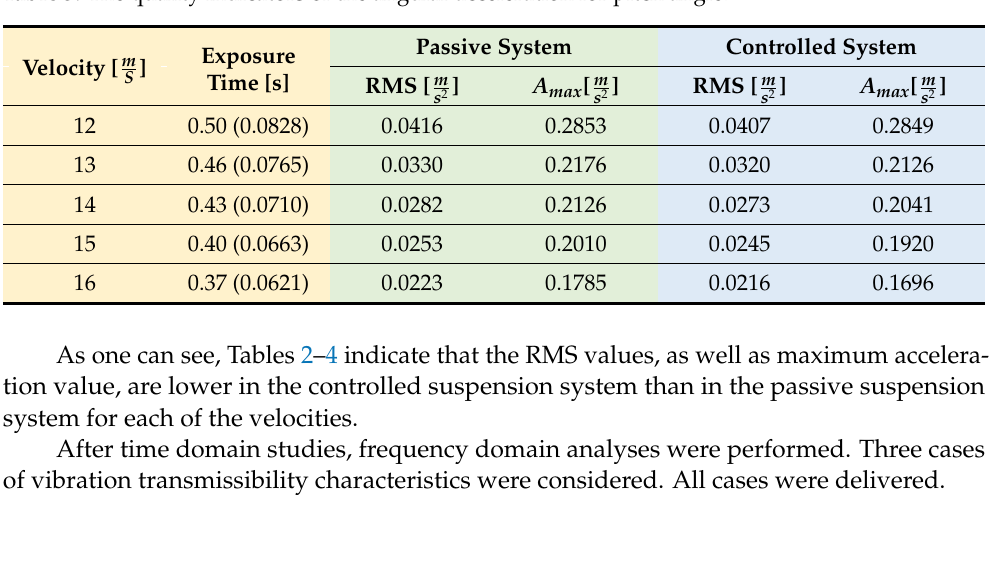
Table 3. The quality indicators of the angular acceleration for pitch angle.